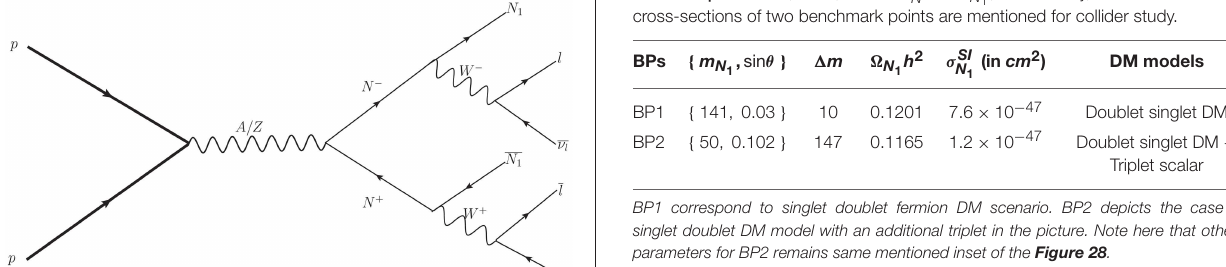
( / E T )) signal events at LHC. +